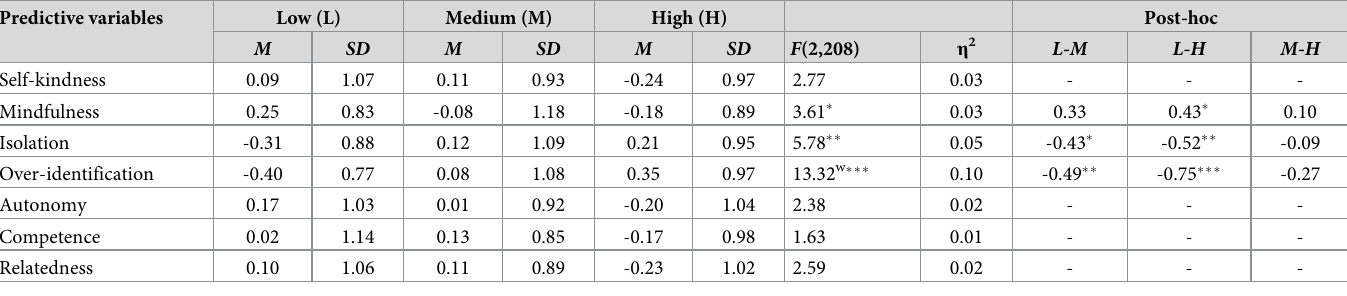
Table 2. ANOVA comparing the participants’ scores on self-compassion and self-determination according to their level of compassion fatigue. Predictive variables Self-kindness Mindfulness